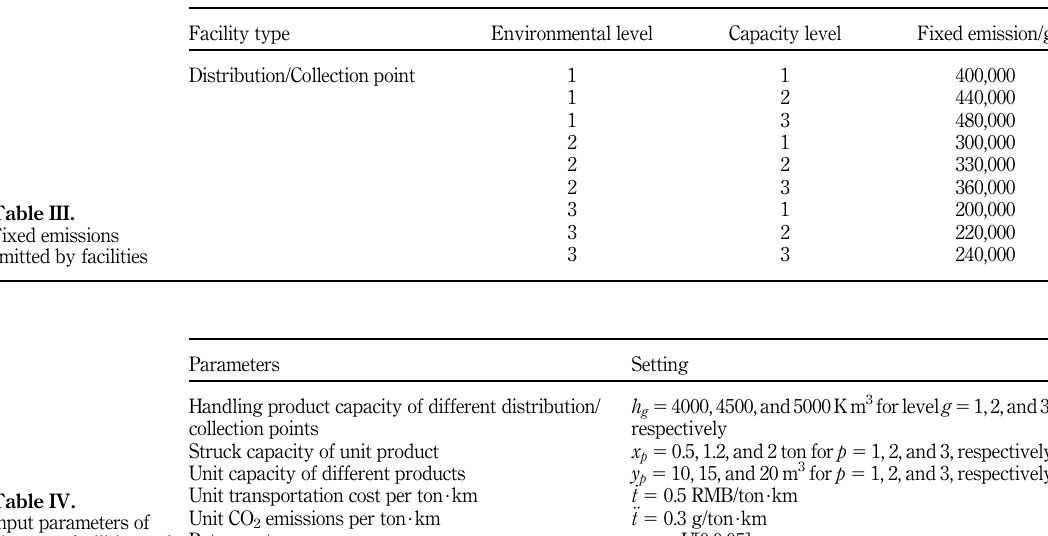
Table IV. Input parameters of disparate facilities and